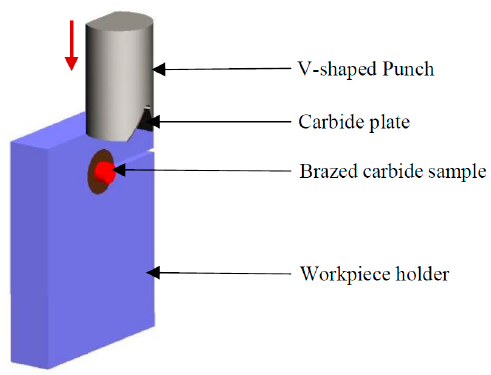
Figure 5. Test rig used for shear tests of the brazed samples.